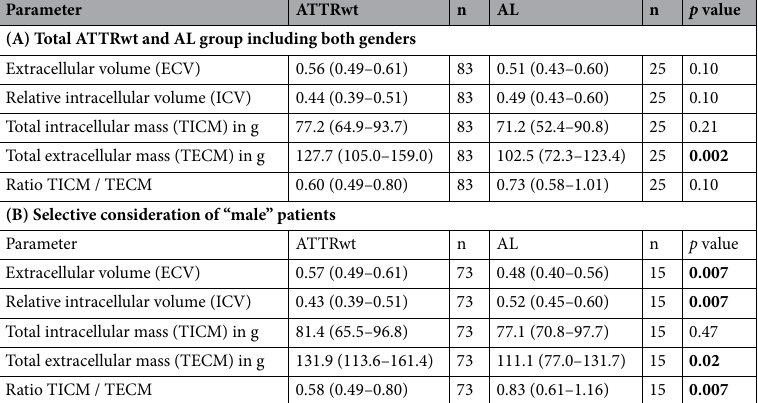
Parameter ATTRwt n AL n p